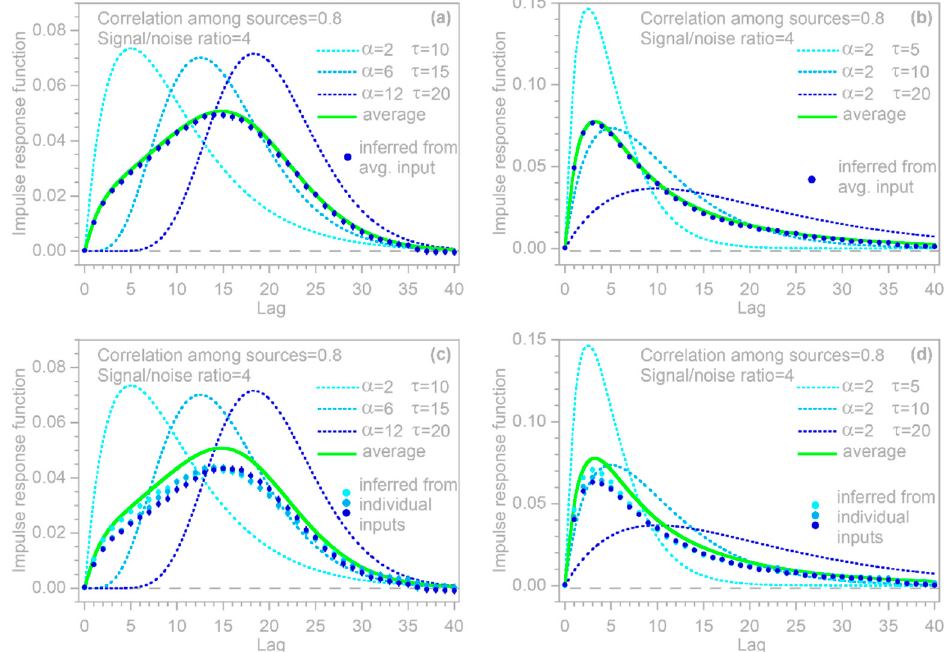
Figure 5. Benchmark test examining whether the average impulse response of the heterogeneous system shown in Figure 4 can be accurately inferred from the average of its three inputs ( a , b ), or from each input individually ( c , d ). As in Figure 4, the left column ( a , c ) shows three sources convolved with kernels exhibiting roughly similar dispersion, but different lag times, and the right column ( b , d ) shows three sources convolved with kernels exhibiting different degrees of dispersion. The impulse responses of the three heterogeneous inputs are shown by the thin dotted lines, and their averages (representing the whole ‐ system impulse response) are shown by the thick green lines. The dots show the IRFs computed from the whole ‐ system output and averaged input (top panels), and from the whole ‐ system output and the individual inputs (bottom panels, with dot colors keyed to match the impulse responses of the corresponding individual inputs). Error bars are shown if they are larger than the plotting symbols. Values of 𝛼 and 𝜏 in ( a ) and ( b ) are parameters of the gamma distributions used for the benchmark impulse responses.